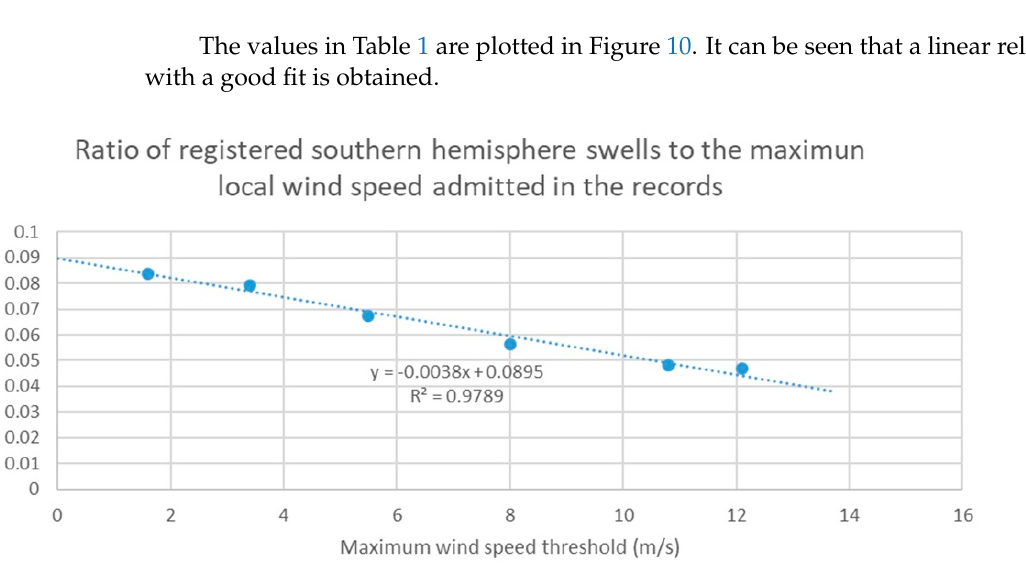
Figure 10. Threshold value of wind velocity vs. annual proportion of south swell records.